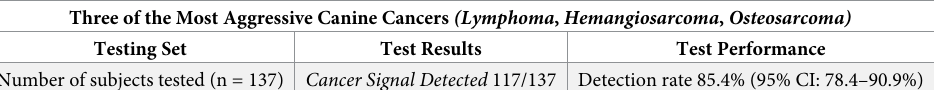
Table 6. Test results and performance in the testing set for three of the most aggressive canine cancers. Three of the Most Aggressive Canine Cancers (Lymphoma , Hemangiosarcoma , Osteosarcoma) Testing